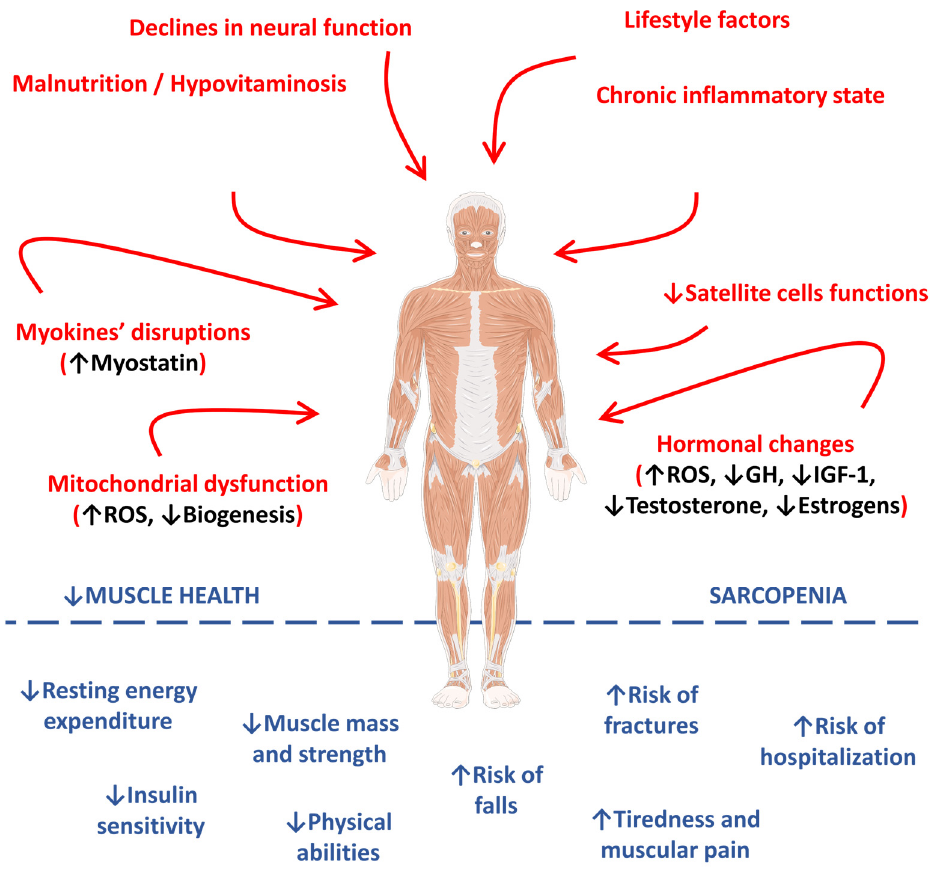
Figure 1. Main pathophysiological pathways involved in the occurrence and progression of sarco- penia. ↑ , increase; ↓ , decrease; GH, growth hormone; IGF-1, insulin-like growth factor 1; IL-1 β , in- terleukin 1 beta; IL-6, interleukin 6; ROS, reactive oxygen species; TNF- α , tumor factor necrosis al- pha.